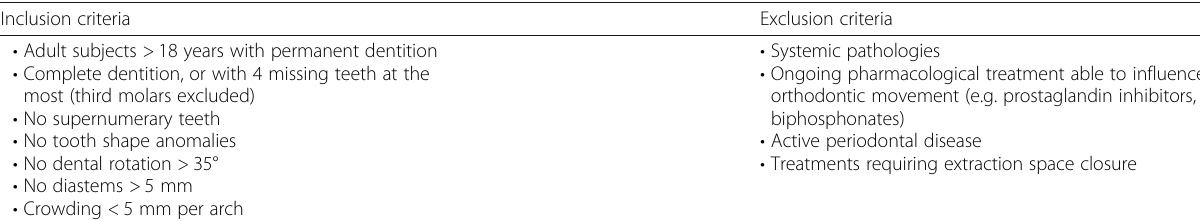
Table 1 Inclusion and exclusion criteria Inclusion criteria Exclusion